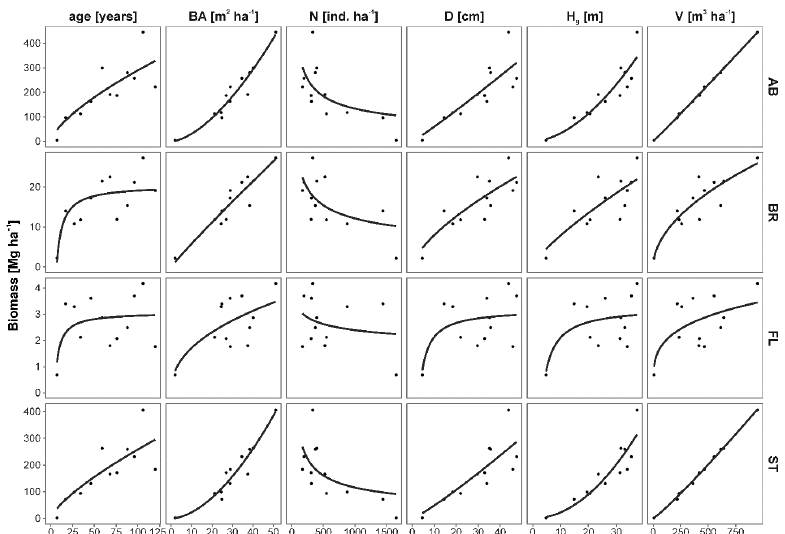
Figure 4. Relationships between forest stand characteristics and forest stand biomass components: total aboveground (AB), branches (BR), foliage (FL) and stem (ST). Parameters of non-linear regression models are presented in Table 4.